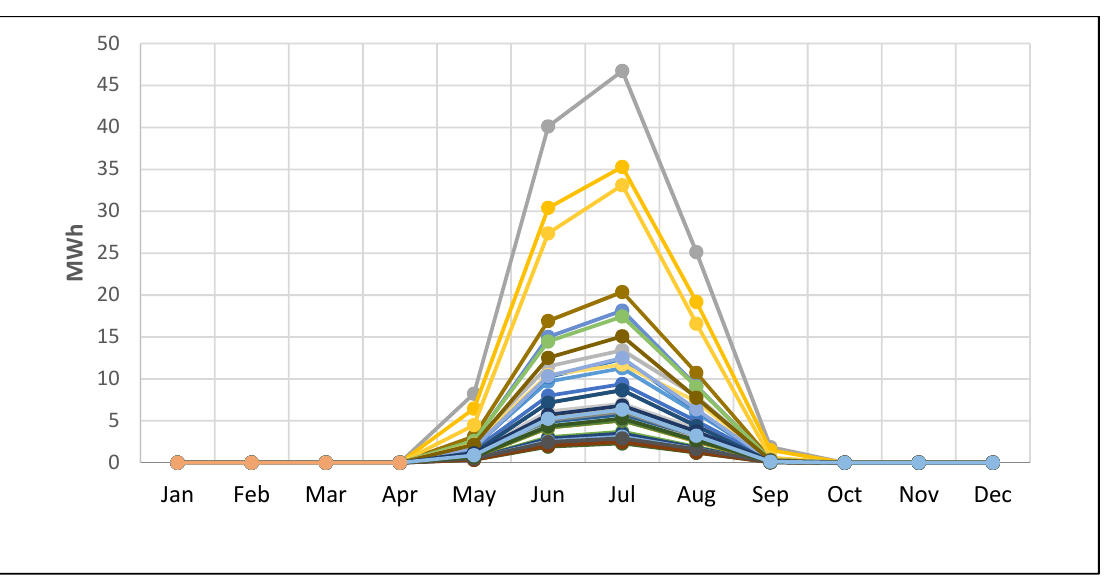
Figure 3. Monthly potential energy production, in kWh, of the 43 potential points found, distributed my